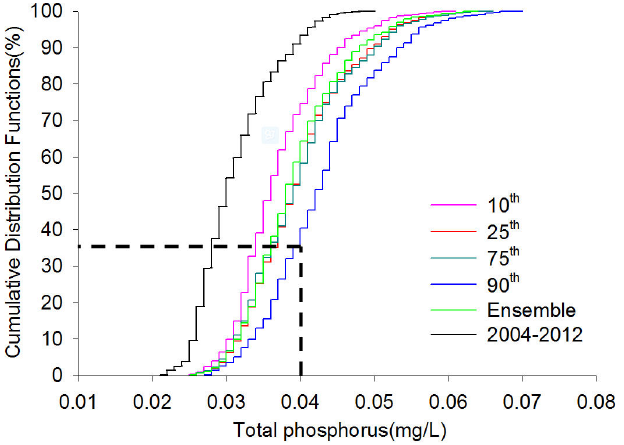
Figure 3. An example of CDF curves for bottom-layer TP concentrations simulated by W2 model and selected AOGCM climate outputs of the long-term future under A1B